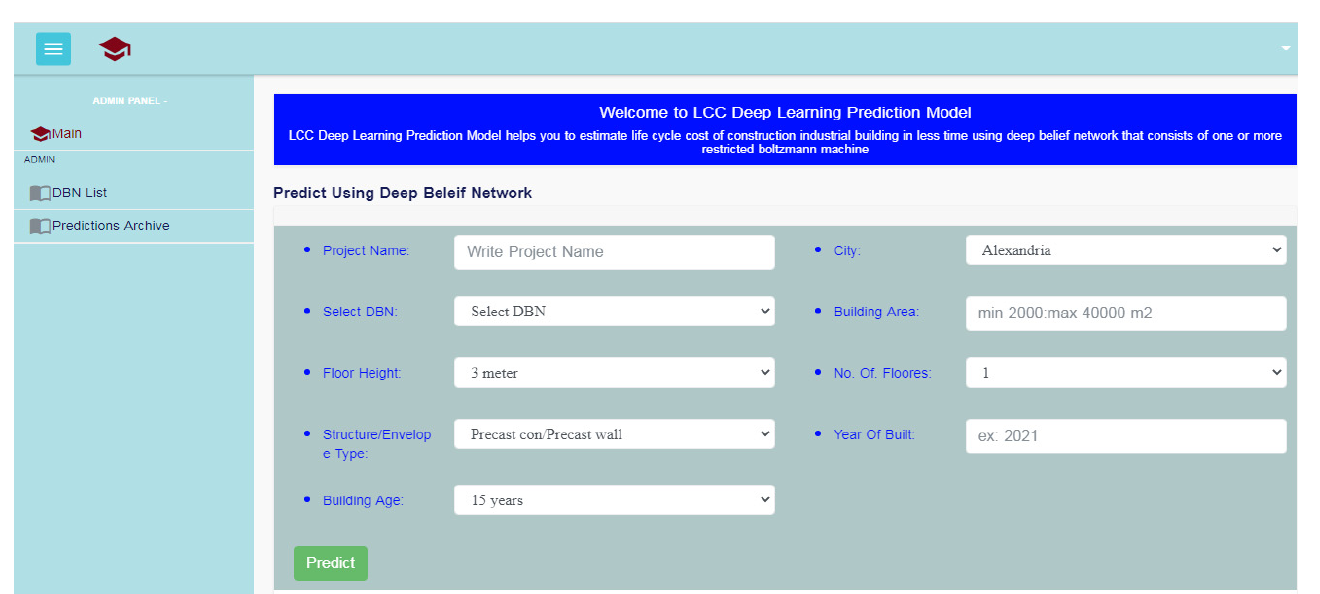
Figure 5. All required inputs of the model.